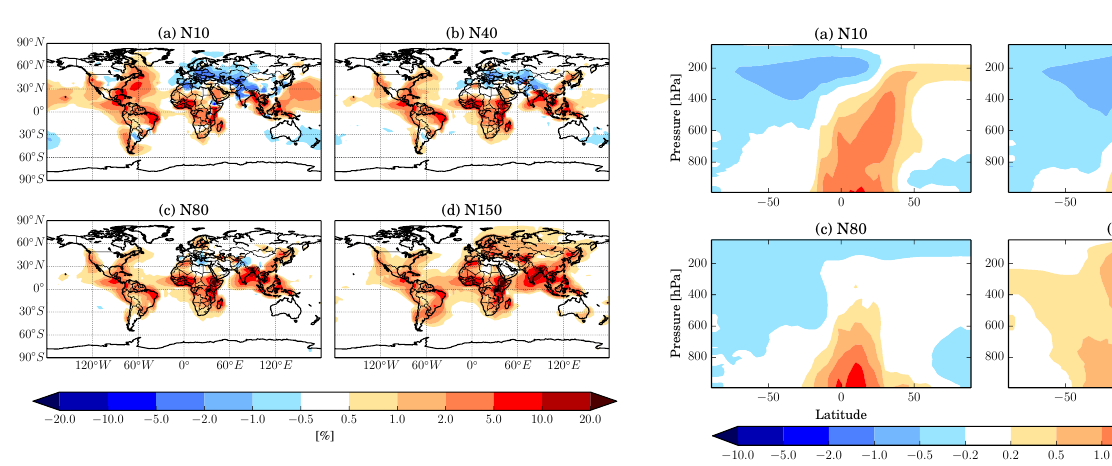
Figure 4. The annual-mean percent change in boundary layer (a) N10, (b) N40, (c) N80, and (d) N150 for the BASE–NOBIOF comparison.